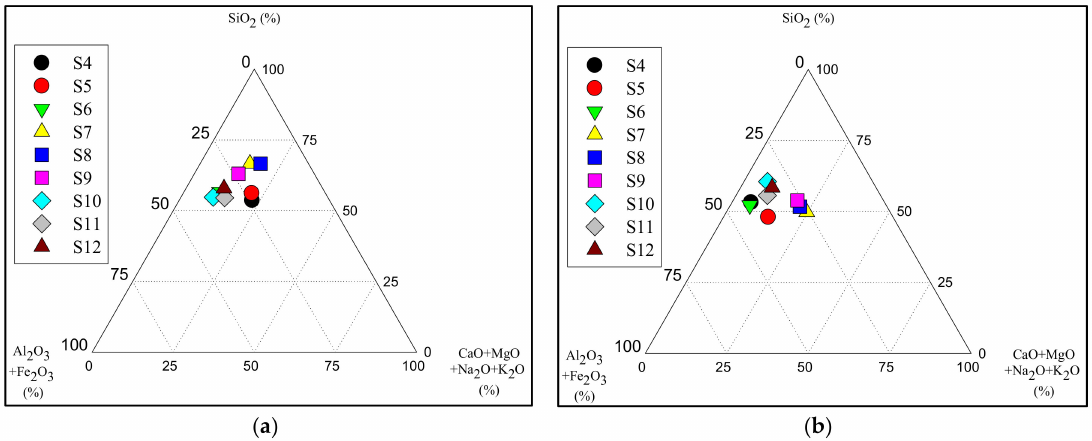
Figure 3. Chemical composition of the fine fractions ( < 63 µ m): ternary diagrams of the major element percentages (% of the sum SiO 2 + Al 2 O 3 + Fe 2 O 3 + CaO + MgO + Na 2 O + K 2 O) in the bottom sediments collected in the dry season ( a ) and in the wet season ( b ). See Table S1 in Supplementary Materials for the basic data with Loss-on-ignition (LOI), MnO, TiO 2 , and P 2 O 5